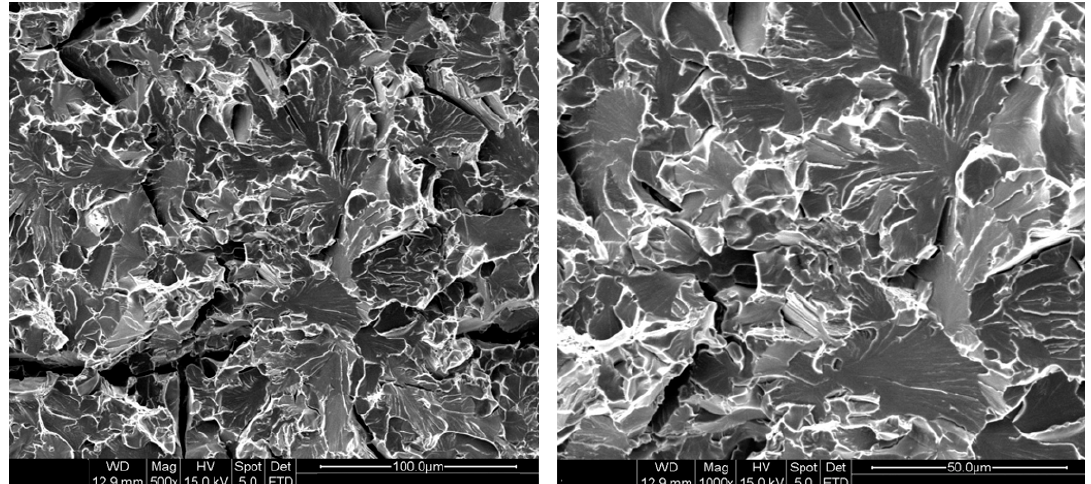
Figure 8. Examples of crack ends branching.